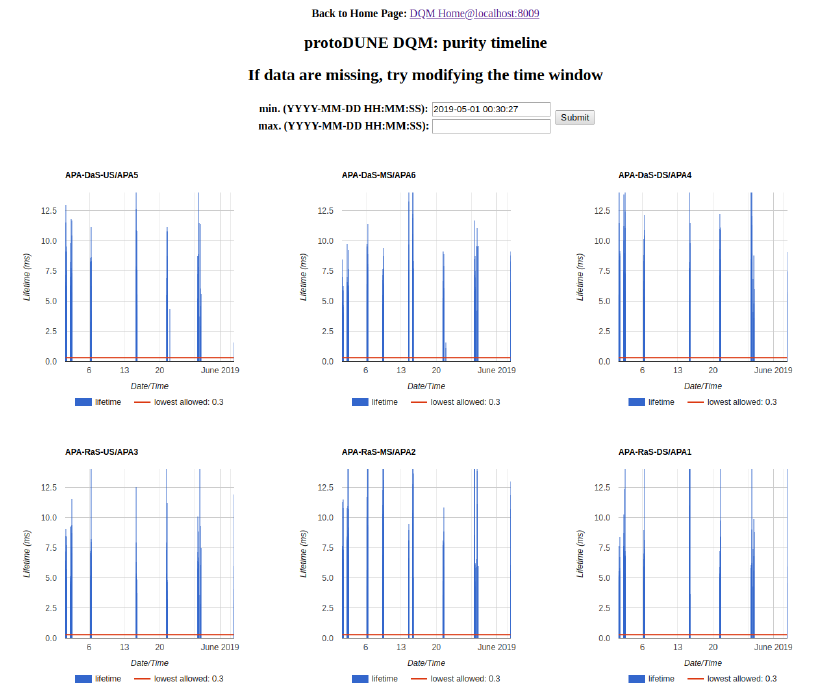
Figure 2. Screenshot of a time series of the electron lifetime in the Liquid Argon of the protoDUNE-SP TPC, based on DQM data for cosmic ray track